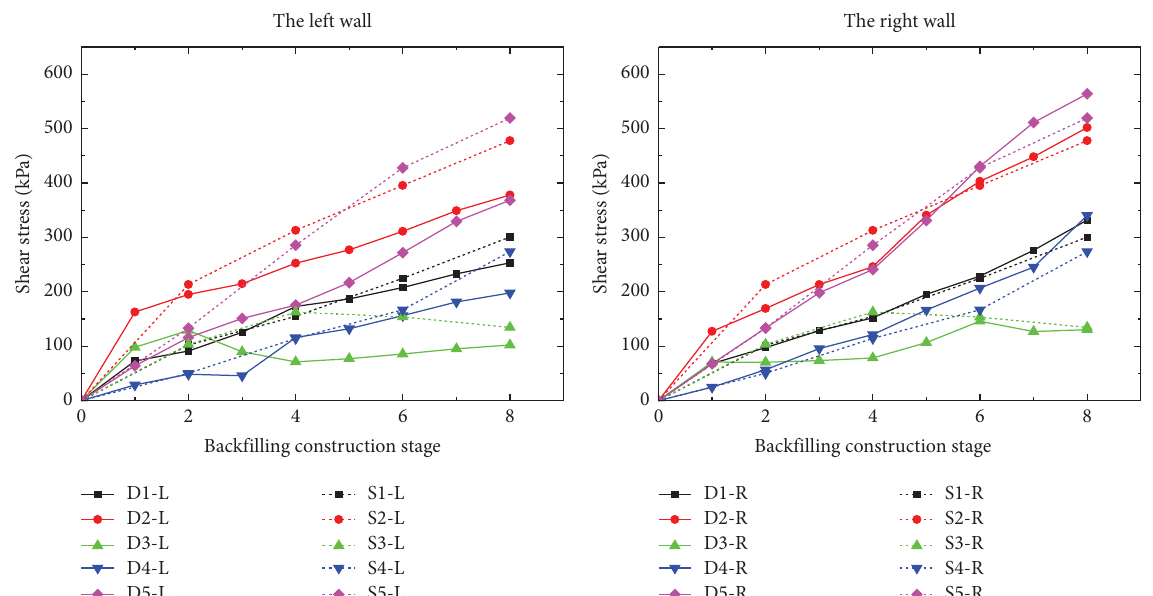
Figure 16: Shear stress of the left/right wall in unilateral and bilateral backfll modes, respectively.